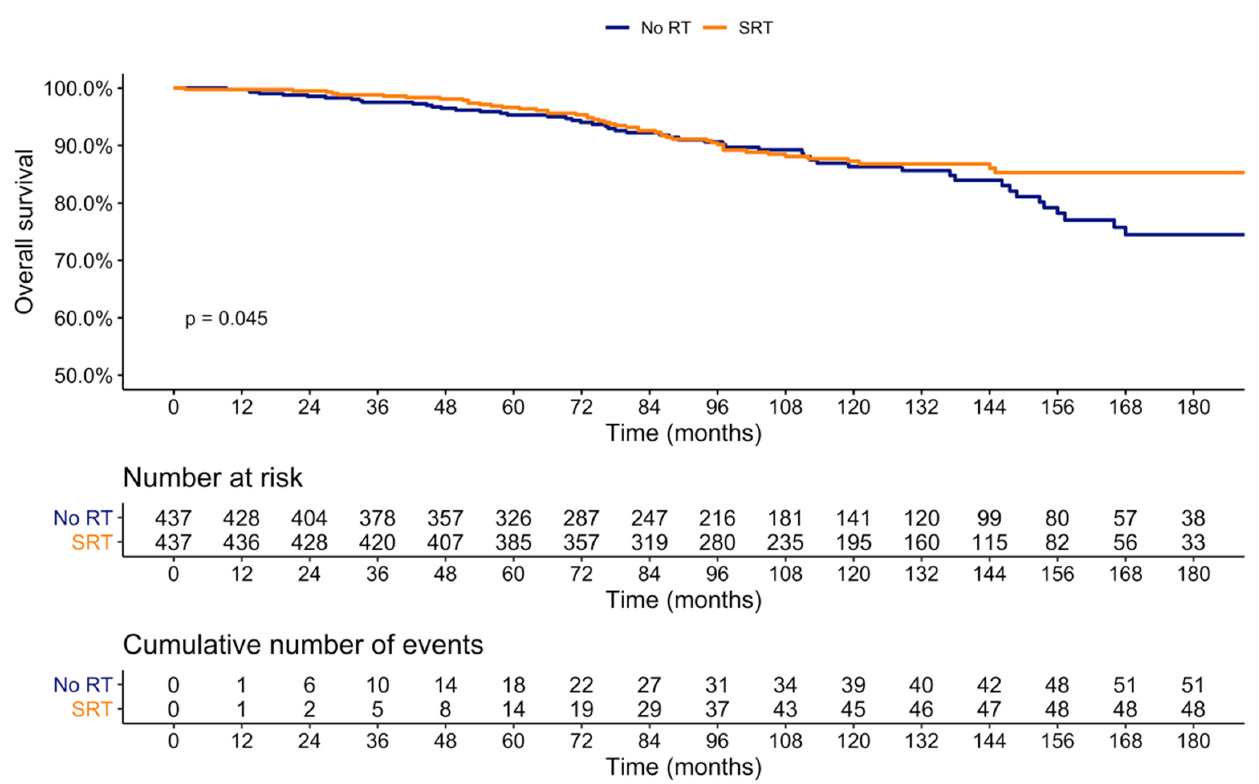
Figure 2. Kaplan–Meier plot depicting overall survival rates in prostate cancer patients treated with radical prostatectomy stratified according to observation vs. SRT for BCR, after 1:1 propensity score matching. Table 3. Uni- and multivariable Cox regression predicting death of patients with biochemical recur- rence after radical prostatectomy and 1:1 matching, stratified according to salvage radiotherapy vs. observation.